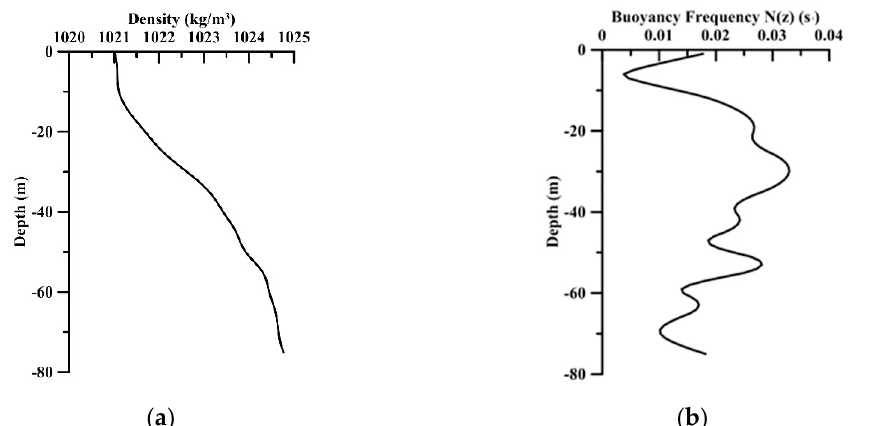
Figure 5. Background profiles of ( a ) density and ( b ) buoyancy frequency in June obtained from the monthly WOA13 V2 dataset.